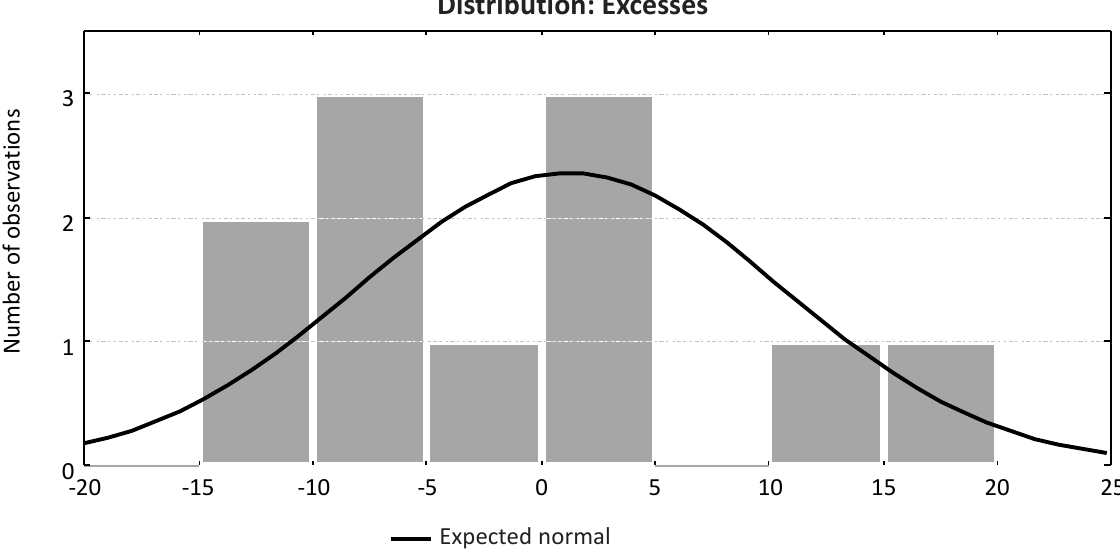
Figure 3. Distribution of excesses for the regression of estimated costs of the Deposit Guarantee Fund ( ) e from the volume of the fund ( )